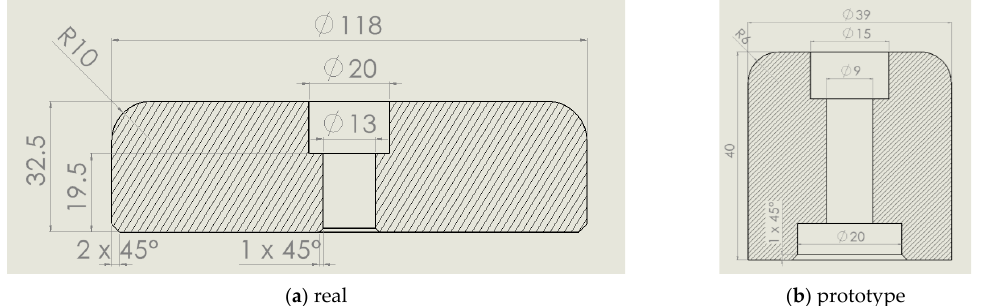
Figure 1. Drafting of ( a ) real RG and ( b ) prototype PG geometries designed for the experimental tests.